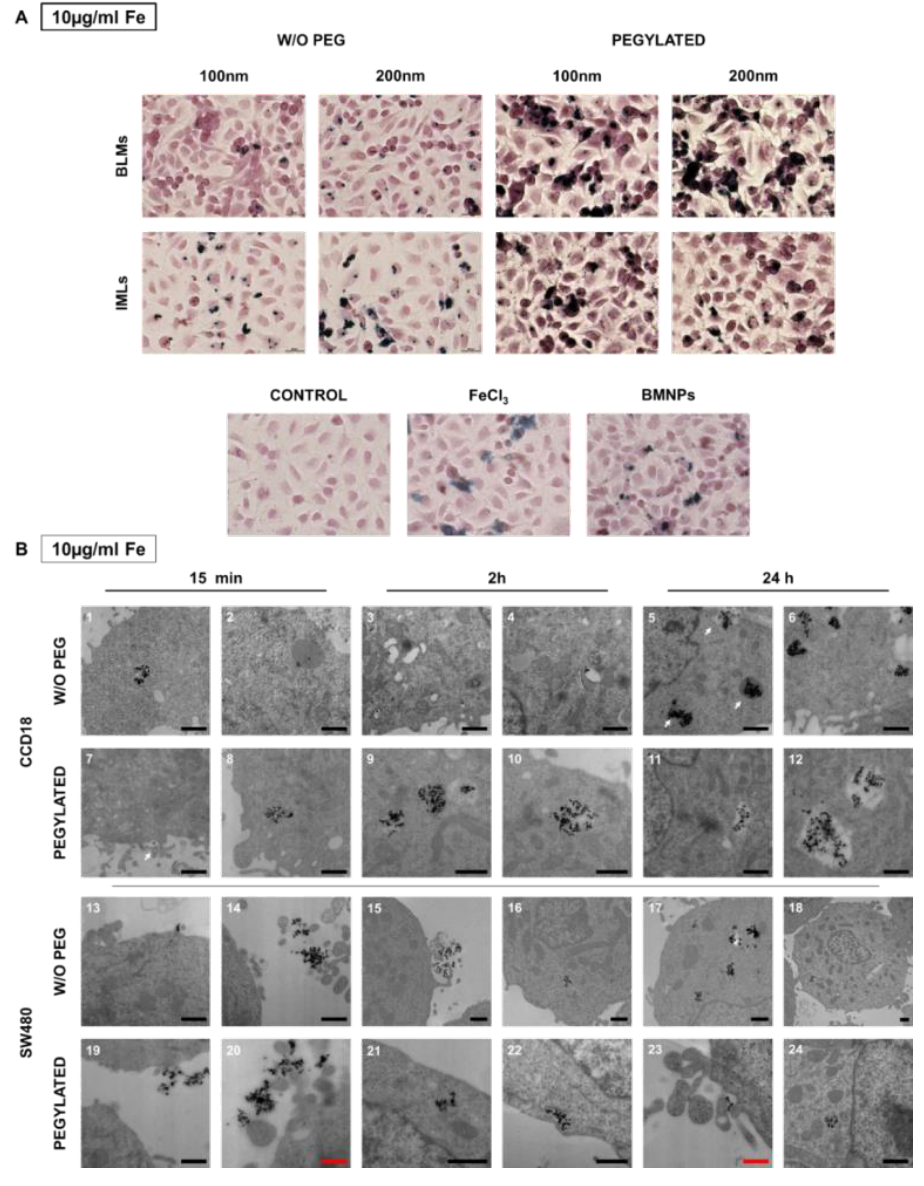
Figure 8. Internalization of BMLs and IMLs in colon cancer cells. ( A ) Representative images of T84 human cancer cells exposed to 10 µ g / mL Fe of BMLs and IMLs (pegylated or not), BMNP (magnetic core) and Fe for 24 h and stained with Prussian blue. Scale bar 25 µ m. ( B ) Transmission electron microscopy analysis of the BMLs 100 nm internalization in colon cell lines. Representative images of CCD18 cell line (1–12) and SW480 colon tumor cells (13–24) showing di ff erent states of internalization of BMLs and BMLs-PEG, 100 nm both, at 10 µ g / mL Fe. Black scale bar, 1 µ m and red scale bar 0.5 µm.